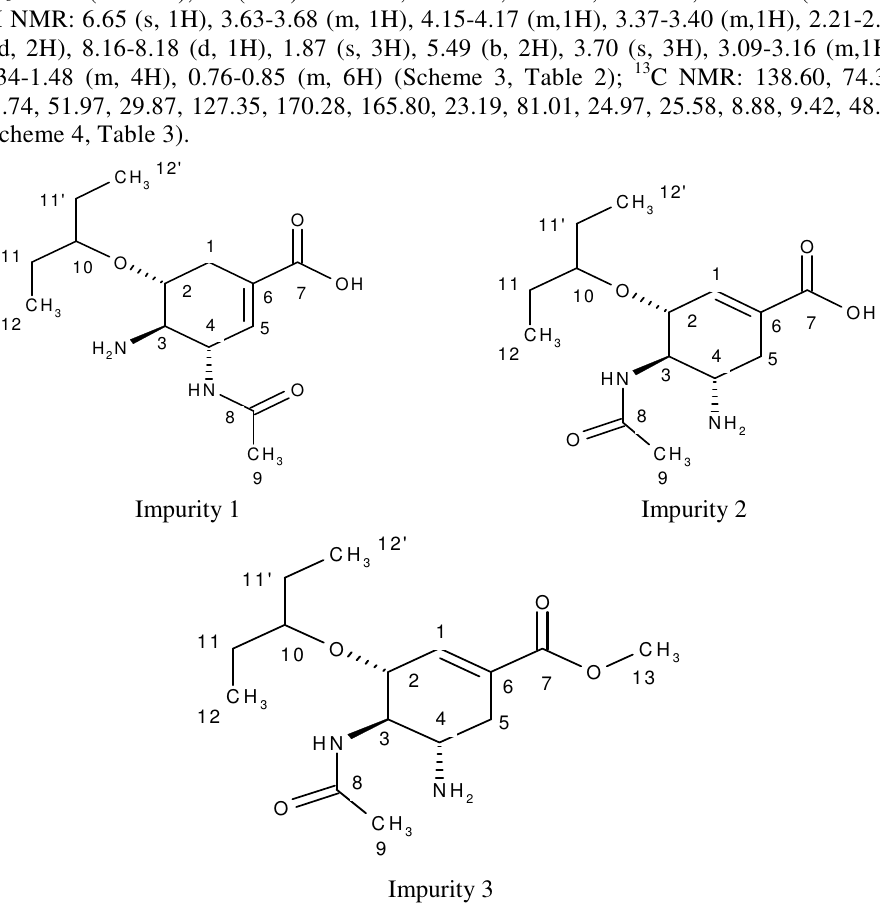
m/z 299.1 (Table 1), IR (KBr): 3434.02, 2966.54,2939.46, 1648.06, 1249.80 (Table 1);